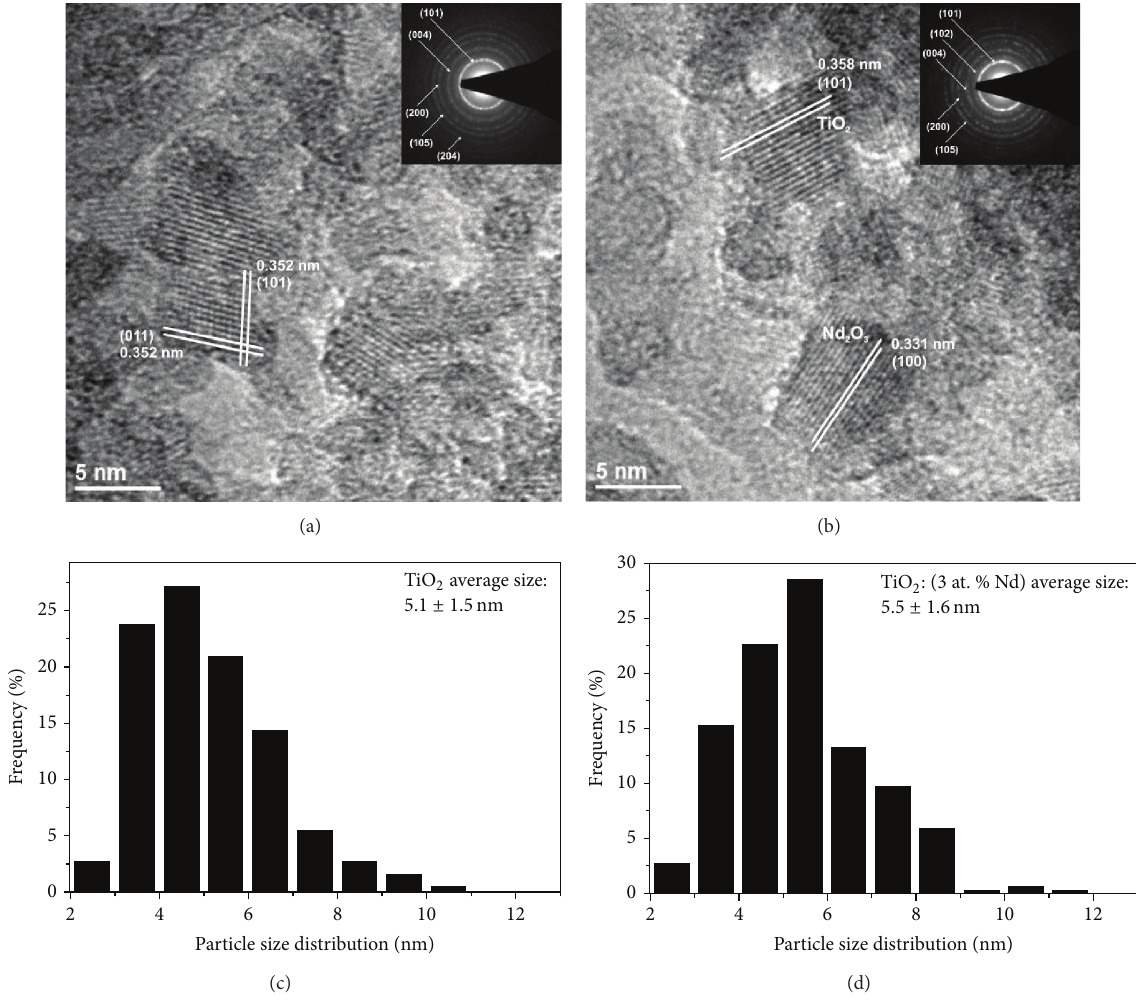
Figure 6: HRTEM images and particles size distribution of (a) TiO 2 and (b) TiO 2 :Nd (3 at. %) nanoparticles.